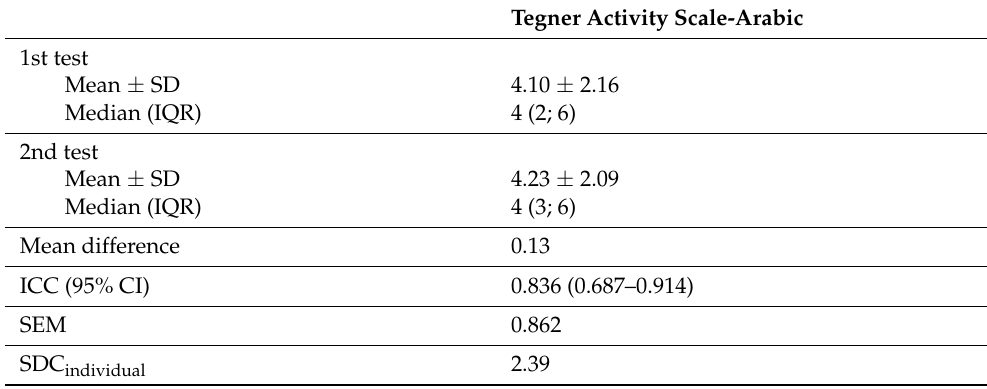
Table 3. The test-retest reliability of the Arabic version of the Tegner activity scale (Patients n =